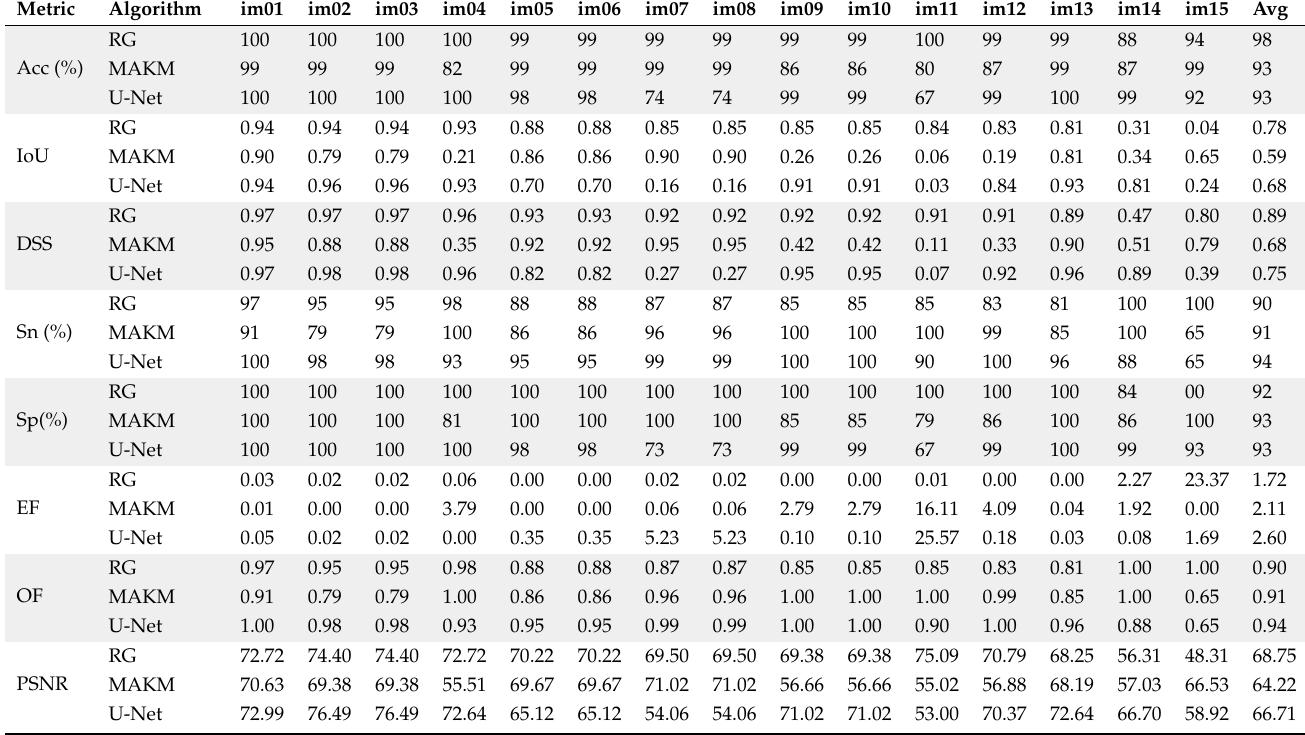
Table 2. Performance comparison of RG with MAKM and U-Net for 15 randomly selected brain images from BRATS2015 Dataset. Metric